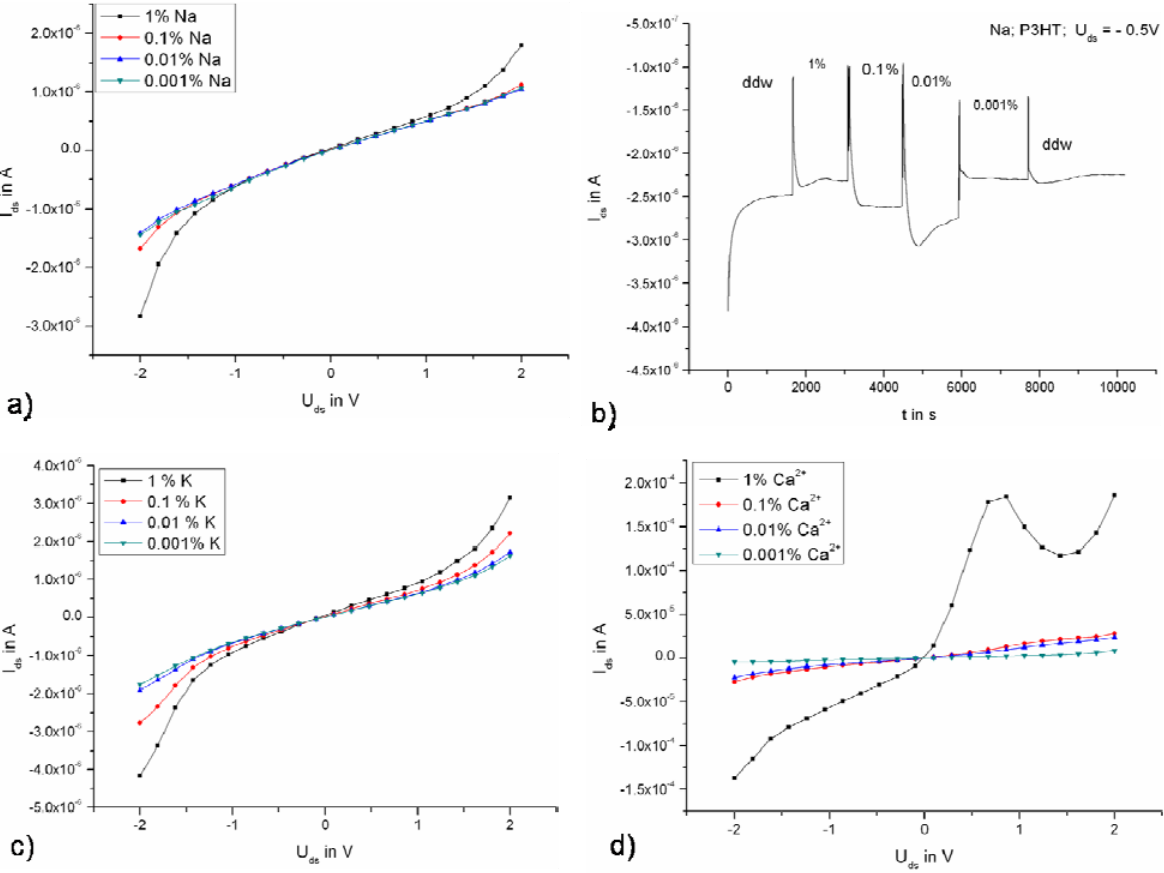
Figure 2. Output characteristics of a P3HT transistor (50 µm channel length) with different ion concentrations of (a) Na + , (c) K + and (d) Ca 2+ . (b) Transistor current versus time, continuously monitored with varying Na + ion concentration